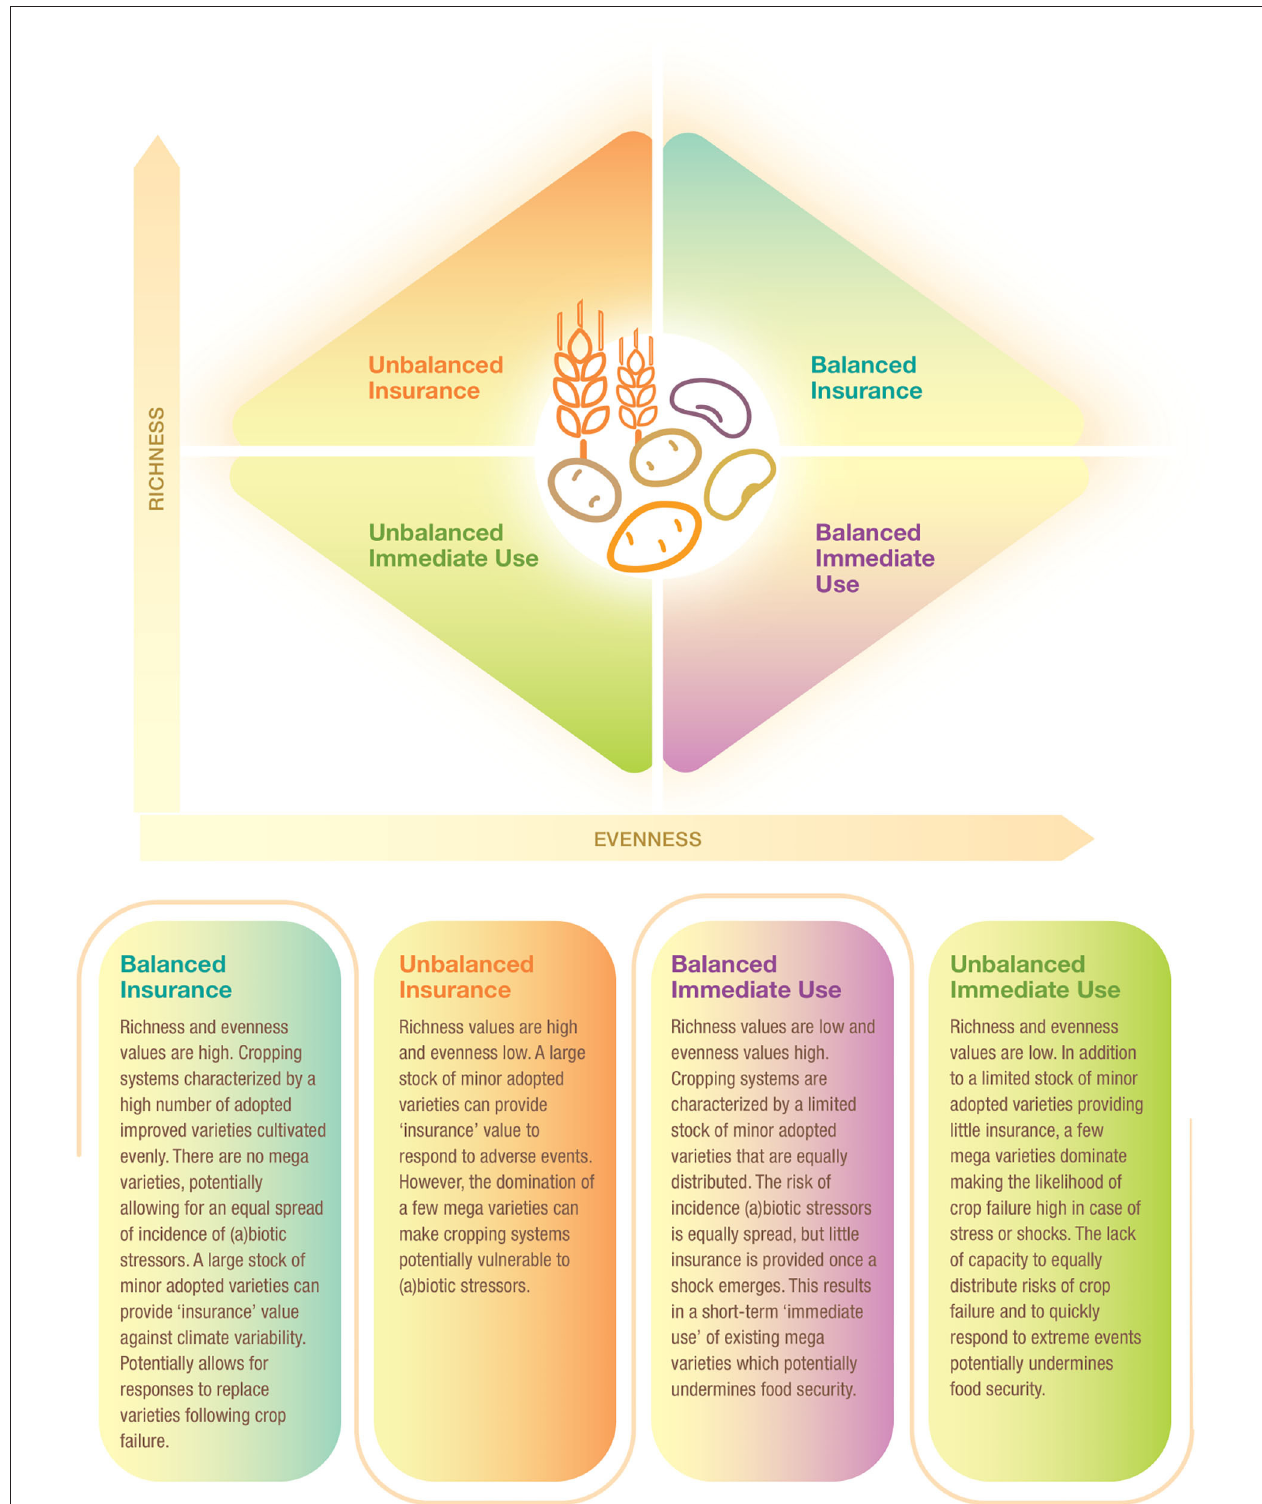
FIGURE 1 | Crop diversity